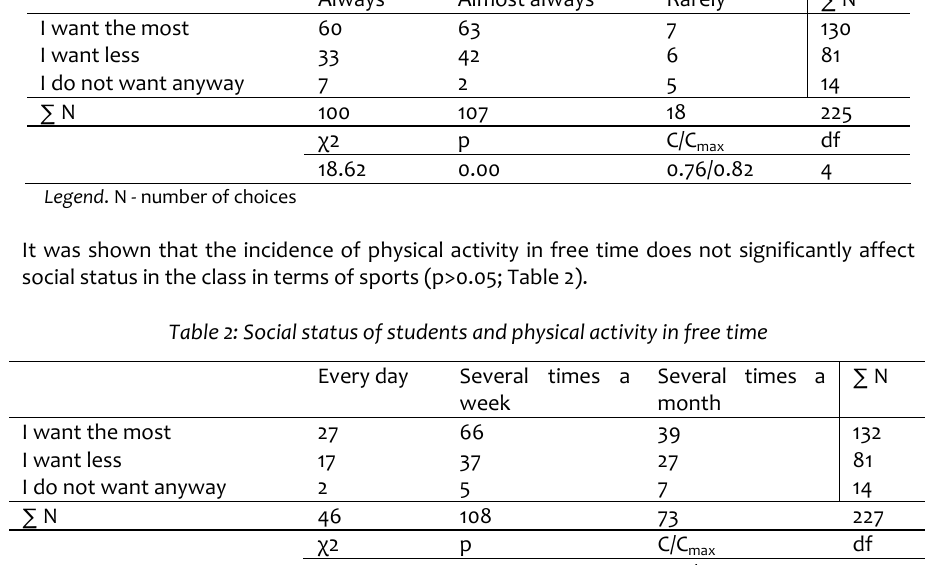
Table 1: Social status of students and physical activity in P.E. classes Always Almost always Rarely ∑ N